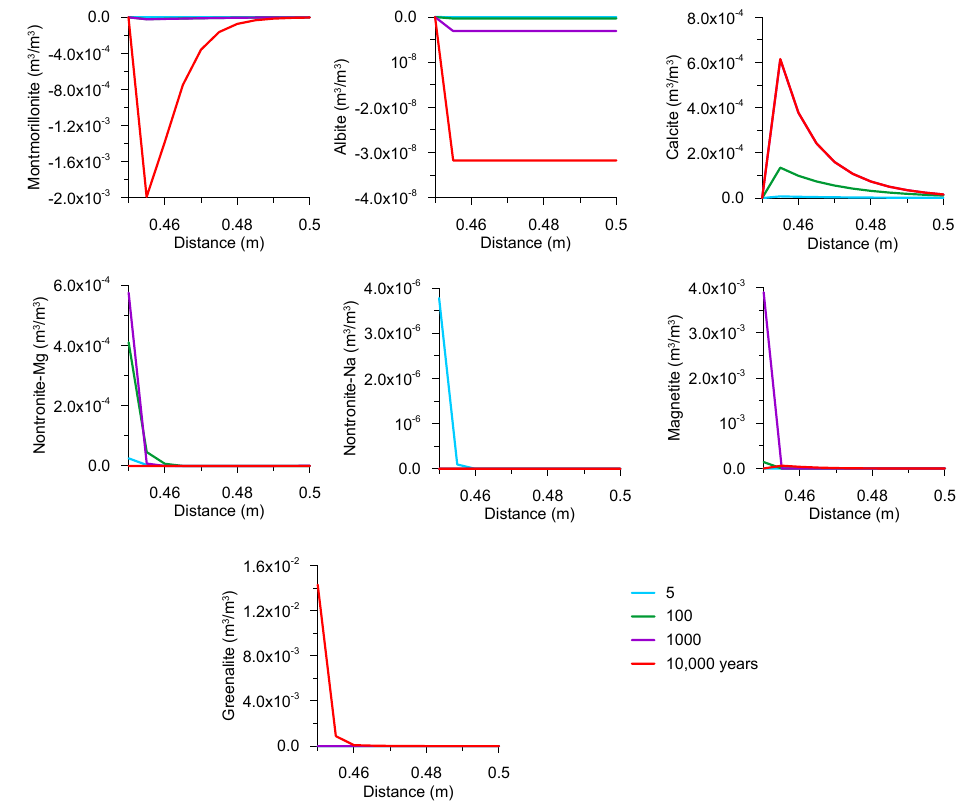
Figure 3. Volumetric fraction of minerals versus distance for the reference model (r c = 2 µ m y − 1 ). For the primary phases (montmorillonite, albite and calcite) the variation of the volumetric fraction is plotted. Positive values mean precipitation and negative values mean dissolution. The interface between steel and bentonite is at 0.45 m. Results at 5, 100, 1000 and 10,000 years of interaction are